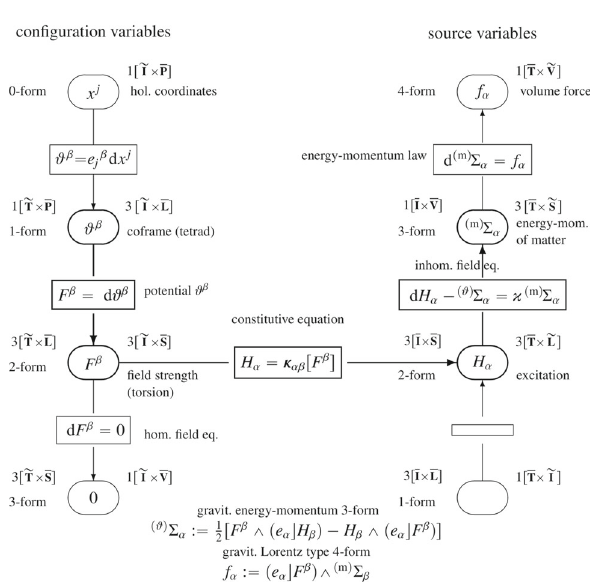
Fig. 1 Patterned after E. Tonti: The Mathematical Structure of Classical and Relativistic Physics, A general classification diagram (Birkhäuser-Springer, New York, 2013) pages 402 and 315. Notation: Y. Itin, F. W. Hehl, Yu. N. Obukhov, Phys. Rev. D 95 , 084020 (2017), arXiv:1611.05759.Wedenotedherethetorsion2-formwith F β inorder to underline its function as a field strength. Usually, however, we use for torsion T β .—wechoseeverywherethe‘teleparallelgauge’suchthatthe ∗ = connection 1-form vanishes globally: Γ αβ ( x ) 0. For the reversible F α ∧ H α and case, we have the gravitational Lagrangian as (ϑ) Λ = − 1 2 Λ = (ϑ) Λ + ( m ) Λ . The gravitational constant is denoted by (cid:21) . (cid:22) Also known as translation gauge theory of